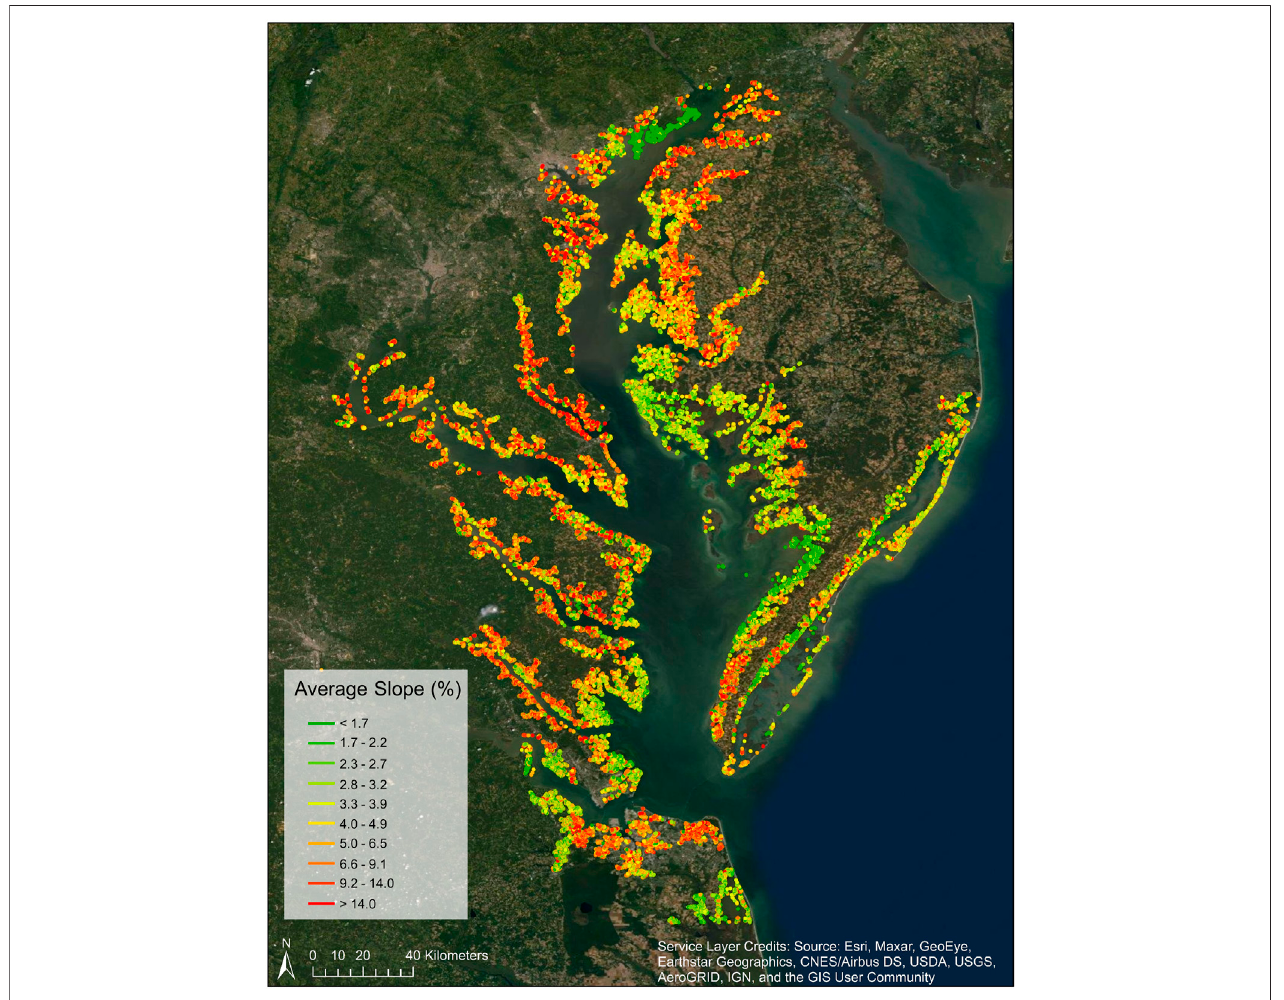
FIGURE 3 | Average slope (percent rise) along transects across marsh-forest boundaries throughout the Chesapeake Bay coastal-plain.